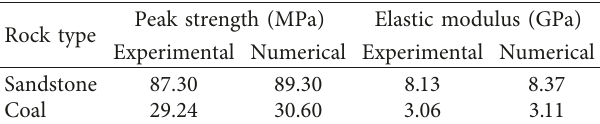
Table 1: Calibrated results